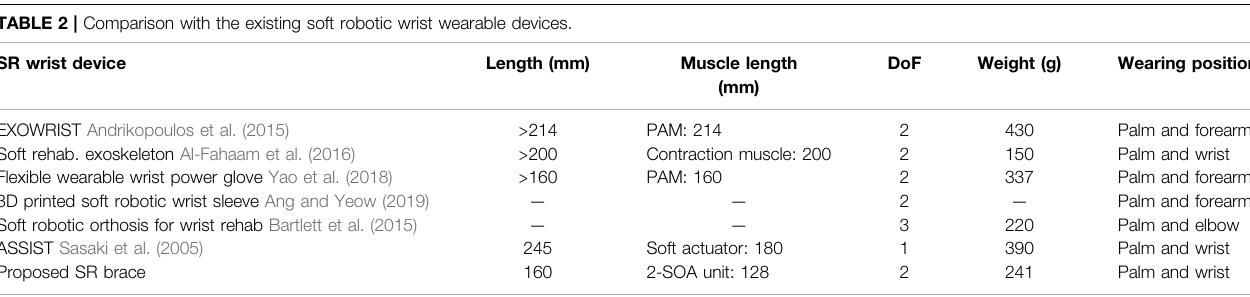
TABLE 2 | Comparison with the existing soft robotic wrist wearable